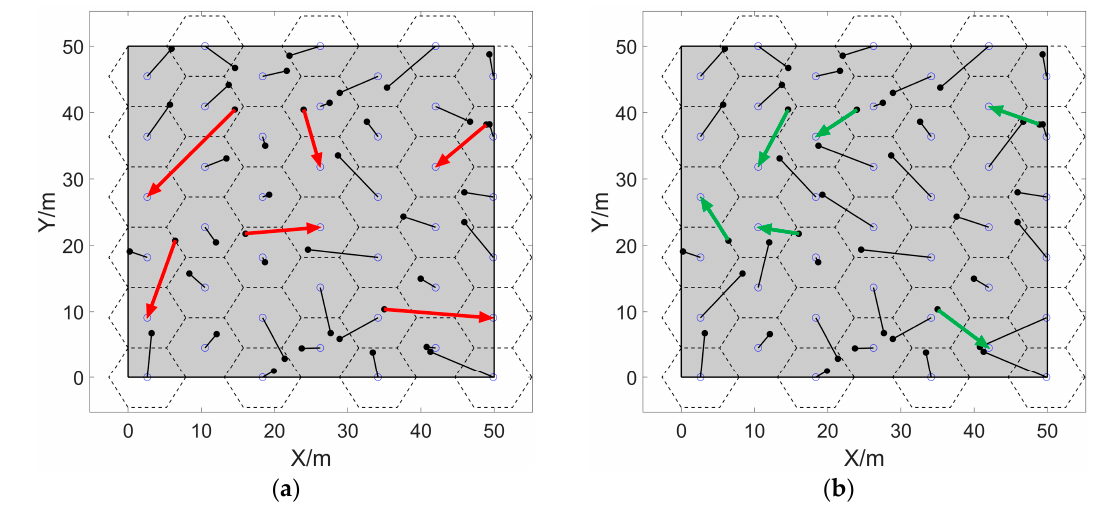
Figure 9. Comparison of moving trajectories before and after task exchange. ( a , b ) are the moving trajectories before and after the task exchange. The hollow and the solid points are the final and initial positions of nodes, respectively. The lines connecting them are the moving trajectories of sensors.